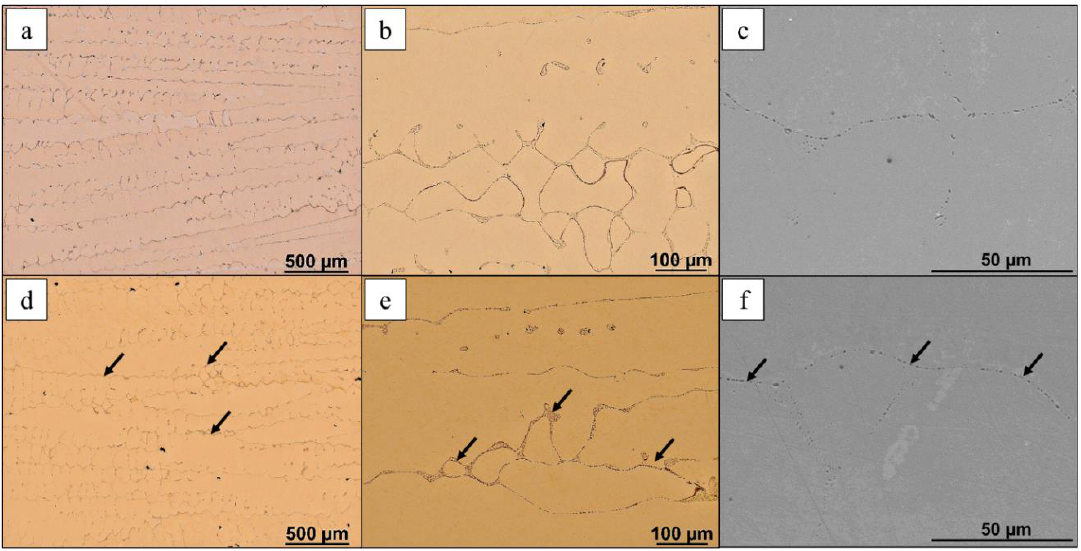
Figure 3. Cross section ( a – c ) and longitudinal section ( d – f ) of ETP grade copper strand. Light microscope, magnification ( a , d ) ×100, ( c , d ) ×500. SEM, secondary electron (SE), magnification ( e , f ) ×1000.